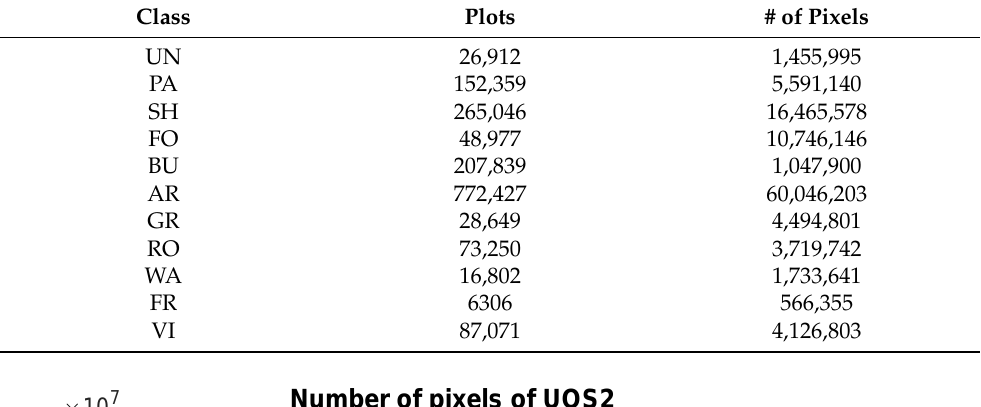
Table 4. Number of SIGPAC plots used in UOPNOA.